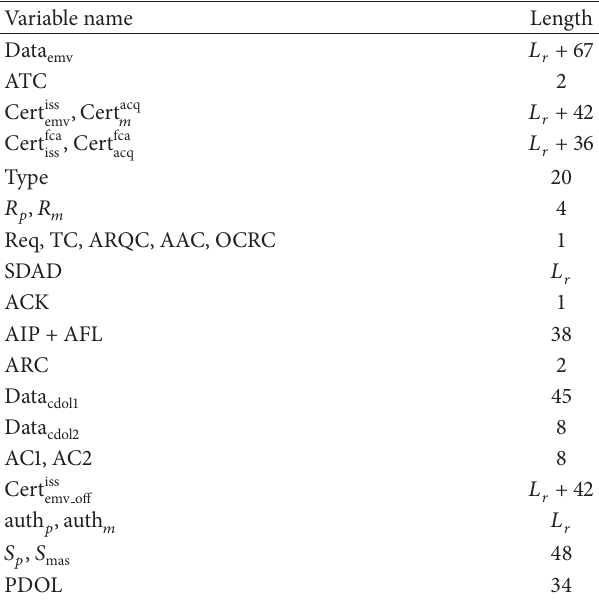
Table 2: Data lengths (bytes).